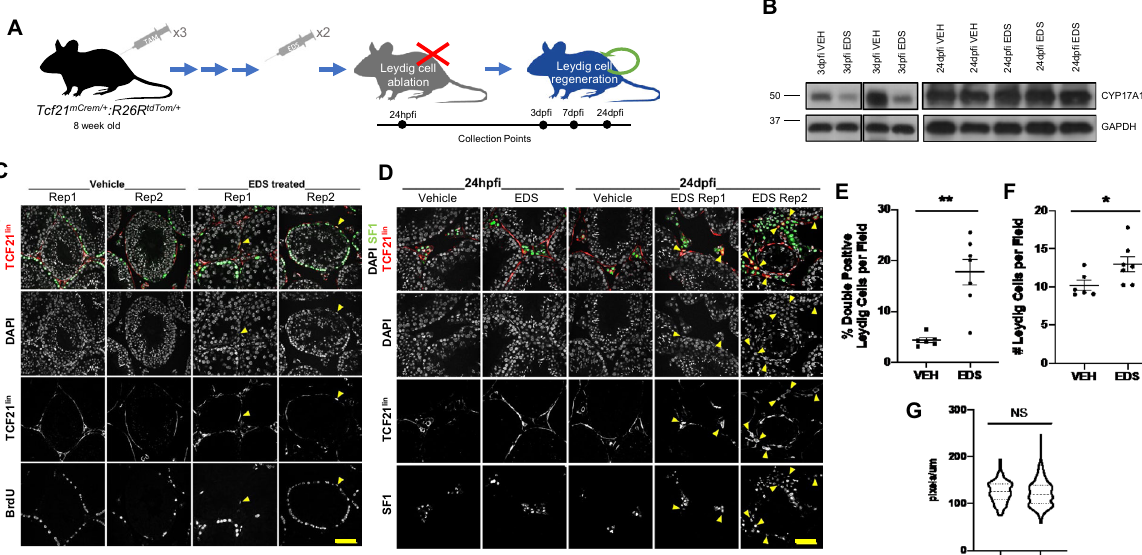
Fig. 5 The TCF21 lin population regenerates Leydig cells in vivo after injury. A Schematic representation of the experimental method used to ablate Leydig cells in the Tcf21 mCrem :R26R tdTom background. B Representative CYP17A1 protein immunoblots from EDS- and vehicle-treated animals at 3 dp fi and 24 dp fi . A total of n = 8 independent experiments were performed. C Representative images of BrdU + cells in the testis of vehicle- and EDS-treated animals (representative from n = 2 vehicle, n = 3 EDS). D Colocalization of TCF21 lin (tdTom) and Leydig cell marker SF1 in EDS- or vehicle-treated Tcf21 mCrem : R26R tdTom animals at 24 h post fi nal injection (24 hp fi ) or 24 days post fi nal injection (24 dp fi ). Representative images from n = 6 vehicle, n = 7 EDS animals. E Quanti fi cation of the percentage of Leydig cells expressing both SF1 and TCF21 lin (tdTom) per fi eld at 24 dp fi (Note — each circle represents the percentage per animal. A total of n = 6 vehicle, n = 7 EDS were analyzed). Data are presented as mean ± SEM. P = 0.0018. F Quanti fi cation of Leydig